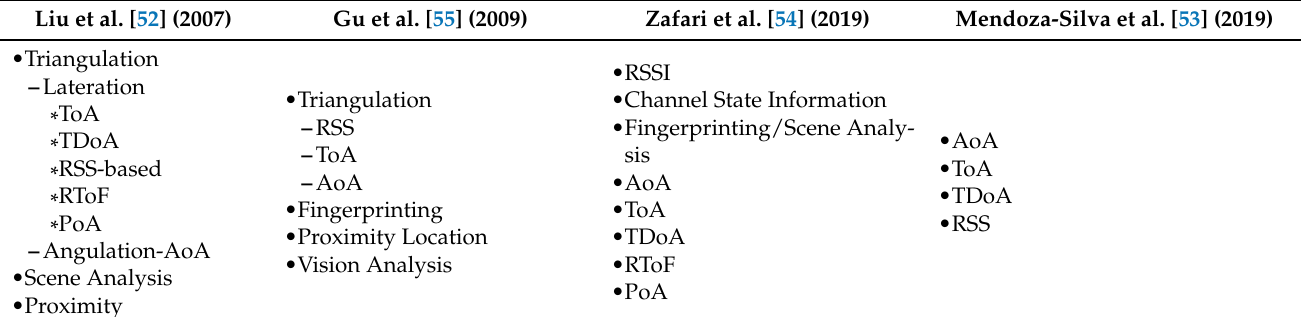
Table 2. Different indoor positioning technique classifications